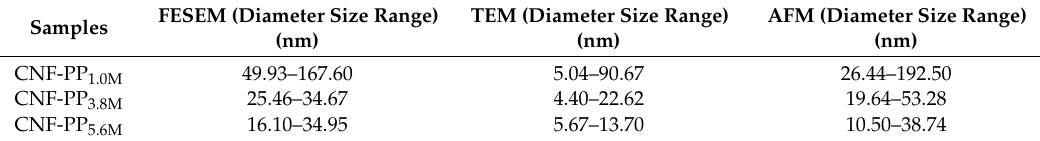
Figure 1. Field-emission scanning electron microscopy (FESEM) ( a – c ), transmission electron microscopy (TEM) ( d – f ), and atomic force microscopy (AFM) ( g – i ) results for CNF-PP 1.0M ( a , d , g ), CNF-PP 3.8M ( b , e , h ) and CNF-PP 5.6M ( c , f , i ). Table 2. Diameters of CNF-PP 1.0M , CNF-PP 3.8M, and CNF-PP 5.6M analysed by FESEM, TEM, and AFM microscopy.